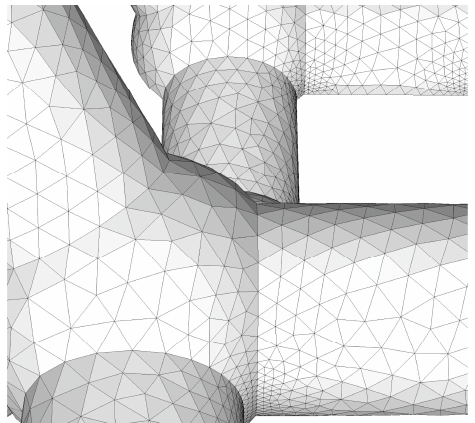
Figure 6. Constructed mesh